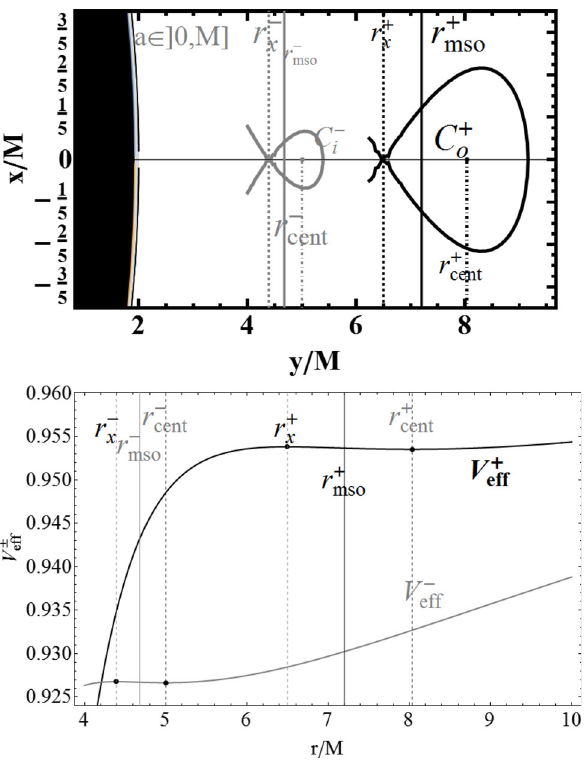
Fig. 2 Upper panel : cross sections on the equatorial plane of the outer Boyer surfaces Roche lobes for (cid:4) counterrotating tori C − × < C + × (as there is r − cent < r + cent , and there is C − × < × C + × for it is r − × < r + × ) orbiting a central Kerr BH attractor with spin a = 0 . 382 M , ( x , y ) are Cartesian coordinates and fluid specific angular momentum (cid:4) − = 3 . 31, (cid:4) + = − 3 . 99, parameters K − = 0 . 927516 and K + = 0 . 953141. Bottom panel: effective potential V ef f as function of r / M . This special tori couple is investigated also in Figs. 4 5, 11 and 14-bottom